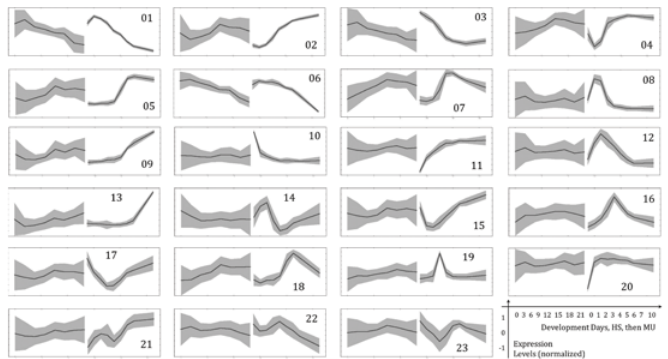
Fig 2. Mouse clusters. 23 clustered expression profile sets are shown. The right part of each graph is the expression profile of (clustered) mouse genes and the left – for corresponding human genes. A line on the graphs is an average expression and grey areas indicate standard deviation of individual expression values with respect to average. Before clustering the standard deviation of expression profiles was set to 1, in order to make the results independent of specific probe set properties.